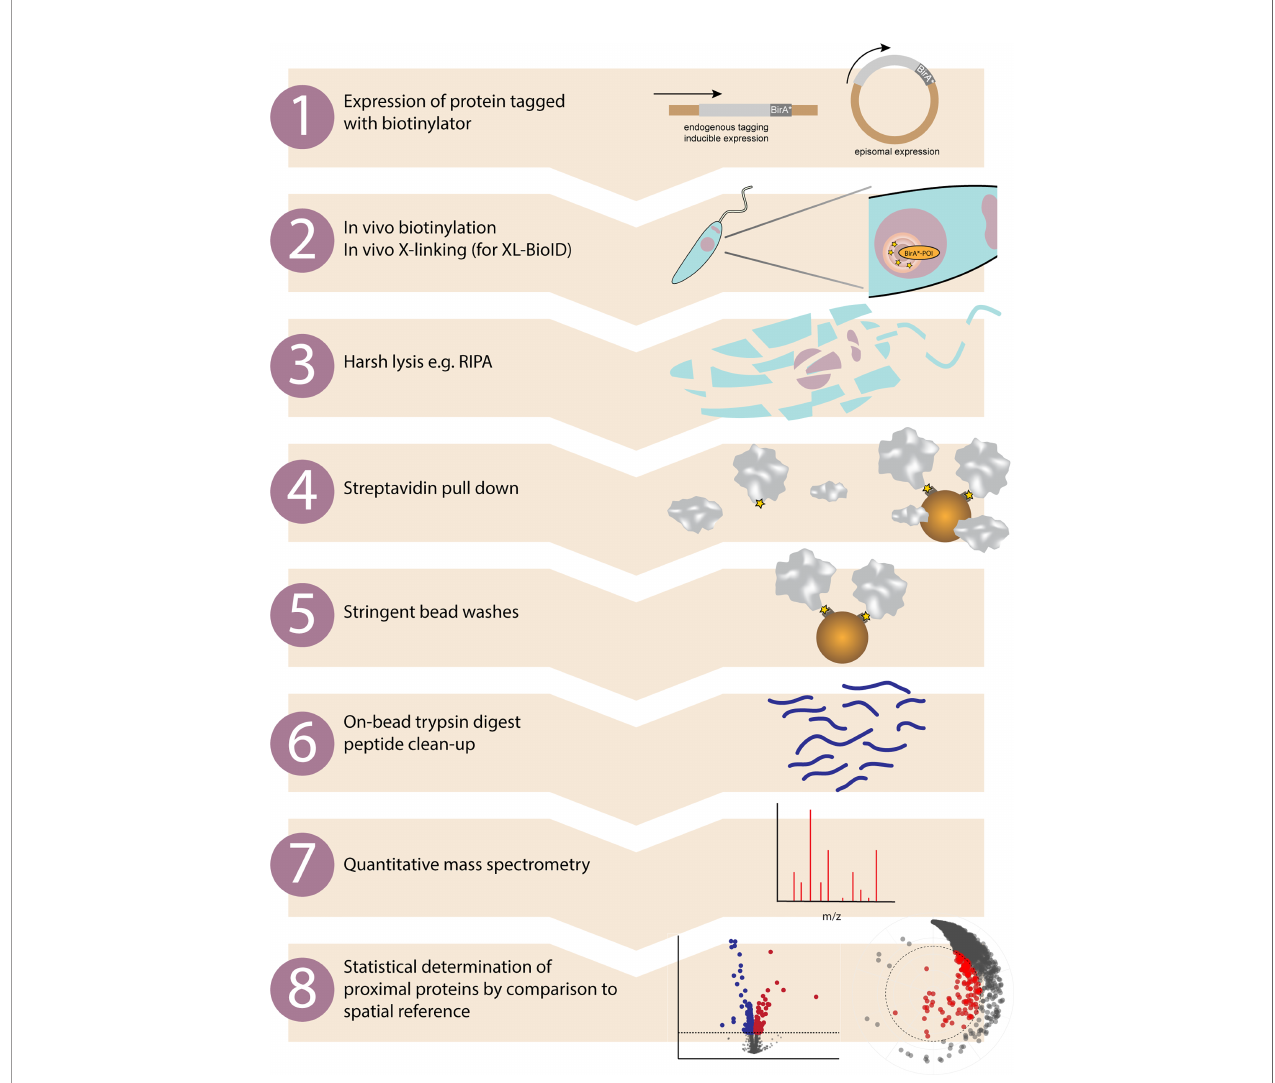
FIGURE 1 | Proximity biotinylation work fl ow in kinetoplastids. Overview of the main experimental steps involved in a proximity biotinylation experiment. 1. Protein of interest is either tagged at the endogenous locus with a biotinylator such as BirA* or APEX2, or a tagged version is expressed from a different locus. 2. Adding exogenous biotin to the growth medium (BirA*) or biotin-phenol then H 2 O 2 (APEX2) initiates in vivo proximity biotinylation. If performing XL-BioID, this may then be followed by an in vivo cross-linking step to increase capture of proximal proteins. A nuclear protein fused to BirA* is shown as an example. 3. The major advantage of proximity biotinylation is being able to completely lyse and solubilise cells with harsh lysis conditions such as radioimmunoprecipitation assay (RIPA) buffer. 4. Proximal proteins covalently tagged with biotin are enriched by incubating lysate with streptavidin beads. 5. Non-proximal proteins are washed off with a series of stringent bead washes. 6. Proteins remaining on beads are digested with trypsin and released peptides are desalted using C18. 7. Peptides are identi fi ed and quanti fi ed by quantitative mass spectrometry. Quantitation may be label free, TMT or SILAC based. 8. Enrichment of identi fi ed proteins vs. a control sample is calculated and statistical testing performed, e.g. with SAINTq or limma. Proteins signi fi cantly enriched in the sample vs. the spatial reference sample are classed as proximal